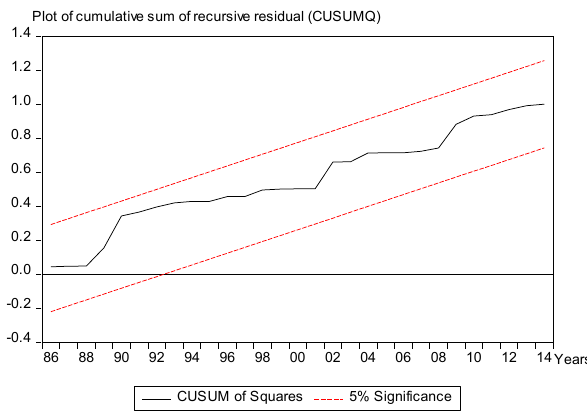
Figure 4. Stability test using (CUSUMQ). Table 6. Findings of the diagnostic tests.